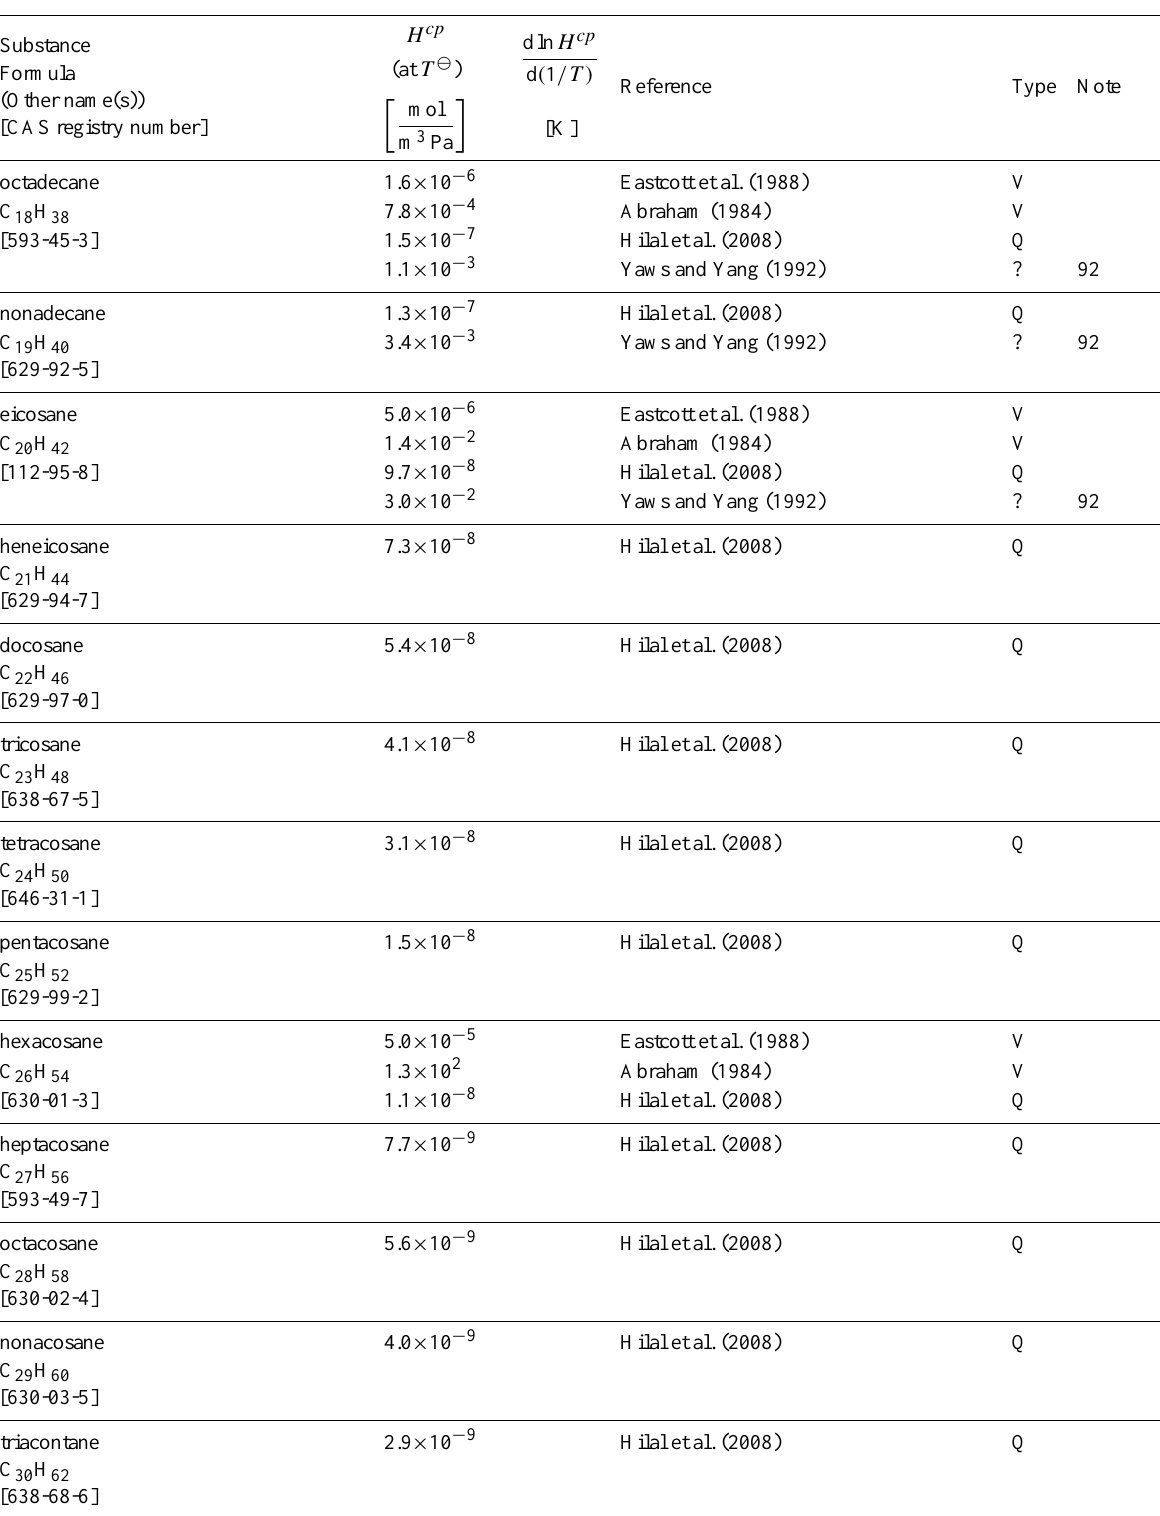
Table 6: Henry’s law constants for water as solvent